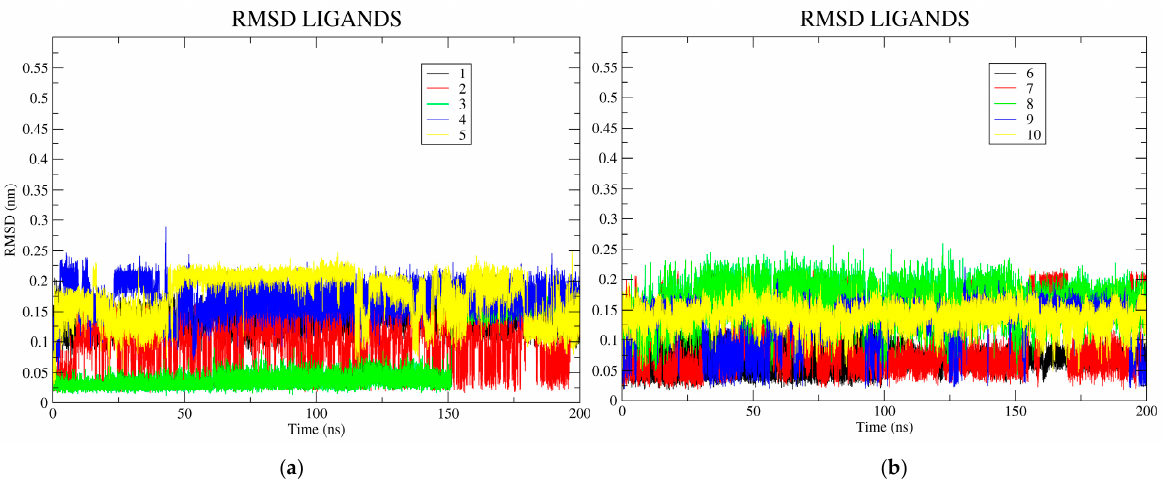
Figure 8. ( a , b ) Indicates the RMSD plots of ligands. They were found to be highly stable. A low fluctuation of 2 Å was observed in RMSD ligand plots. These observations indicate the stability of the hits in the pocket of the receptor.